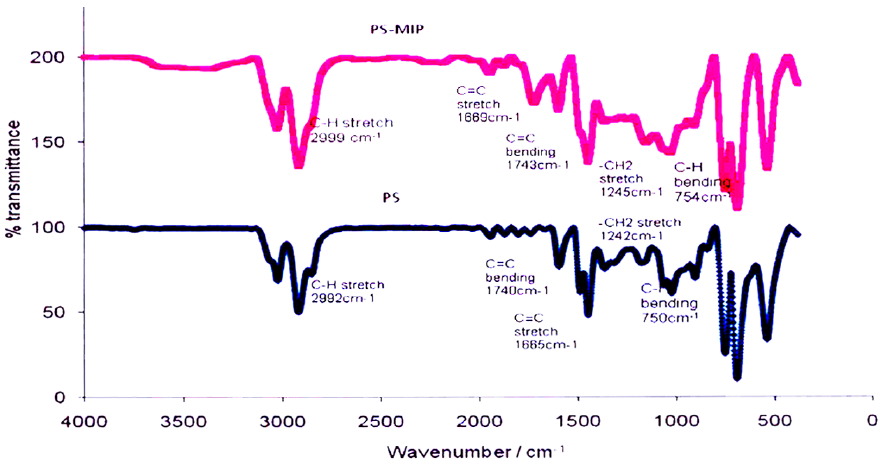
Figure 2. FTIR spectra for PS and PS-MIP.